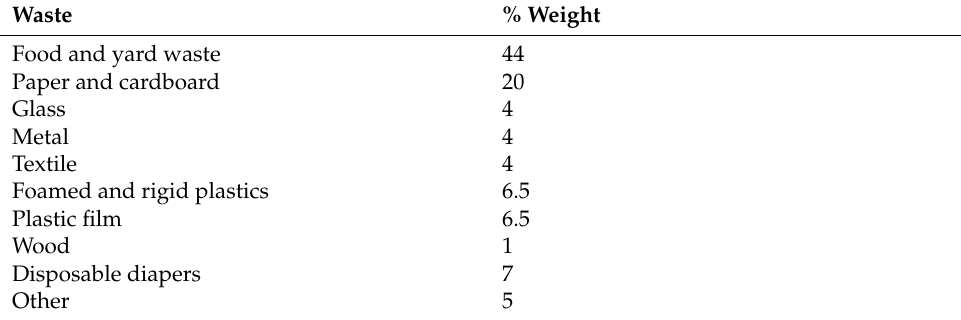
Table 1. Composition of the waste